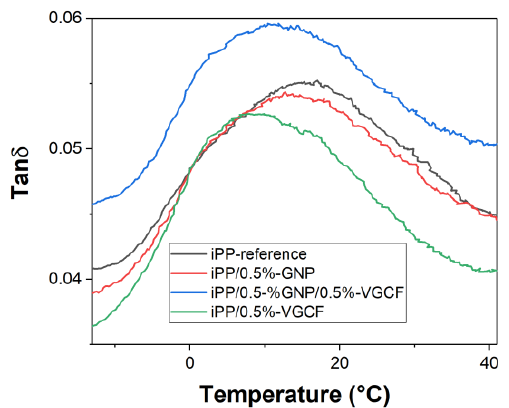
Figure 9. Dynamic mechanical analysis energy dissipation results of one hybrid nanocomposite system.